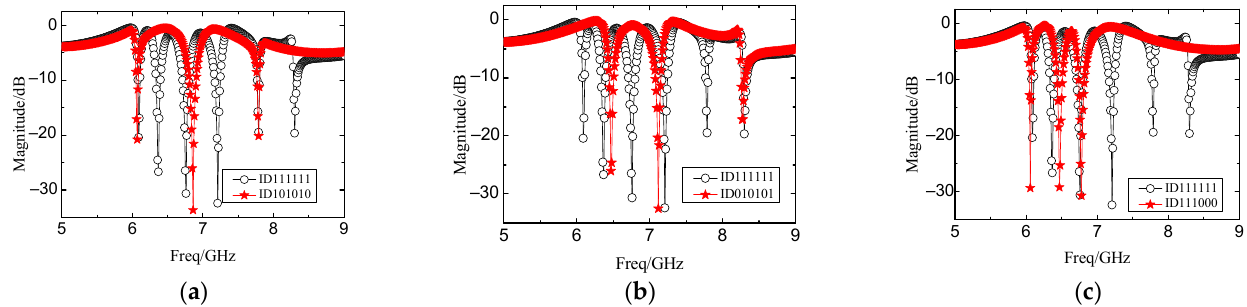
Figure 7. Simulation of the resonance curves of the 6 bits U-shaped slot resonator chipless tags with a short-circuit logic state of “0”: ( a ) ID111111 and ID101010; ( b ) ID111111 and ID010101;( c ) ID111111 and ID111000.